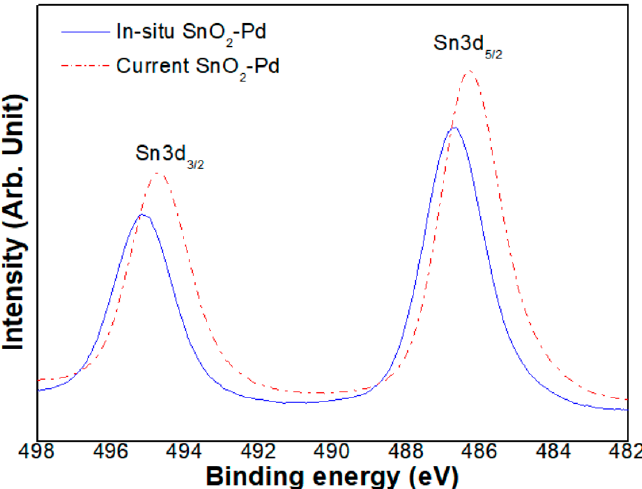
Figure 8. XPS peaks of SnO 2 -Pd NPs synthesized with in situ and current methods,